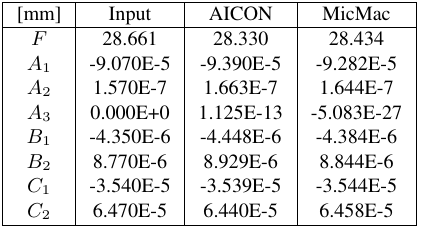
Table 1: Comparison of the “true” and estimated interior camera parameters for Scenario A.